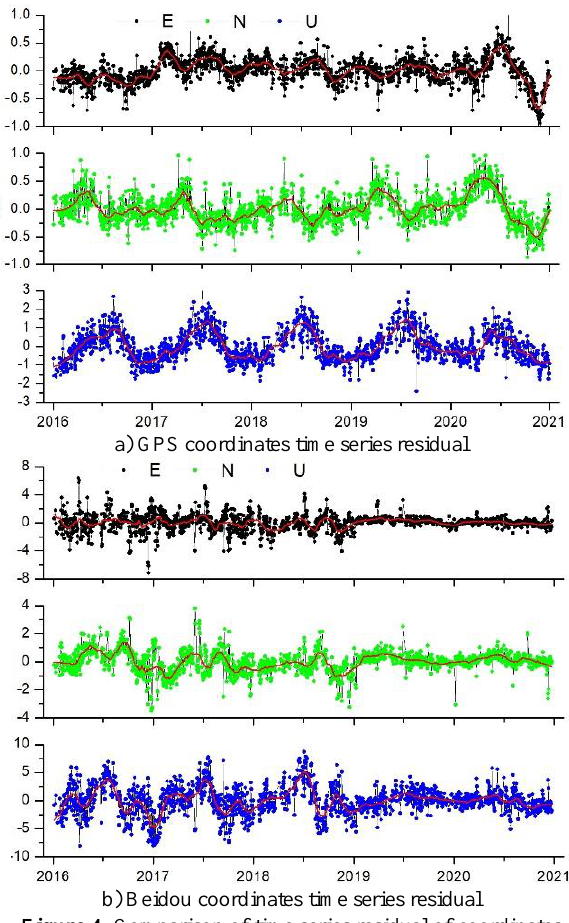
Figure 4 . Comparison of time series residual of coordinates after elimination of linear velocity(cm)